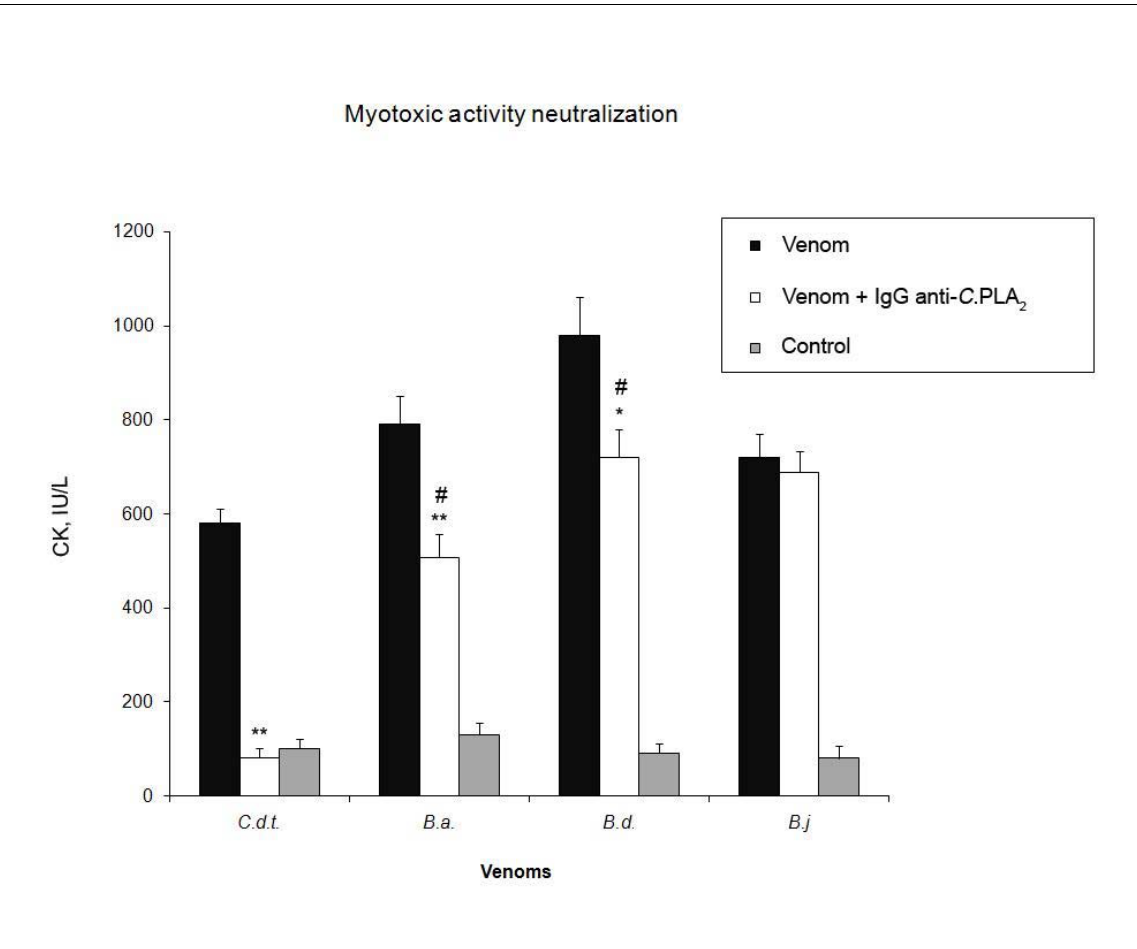
Figure 4. Neutralization of myotoxic activity. Effects of C.d.t . venom and bothropic venoms on mouse skeletal muscle measured by plasma CK levels (IU/L) and their neutralization by IgG anti- C .PLA . Neutralization was carried out at the time of the 2 maximum liberation of serum CK: one hour ( B.j. ), three hours ( B.a .) or six hours ( C.d.t. ; B.d. ). Each point represent the mean + SD of five samples. # p < 0.001, compared with the control group; * p < 0.01 or ** p < 0.001 compared with the group inoculated with venom